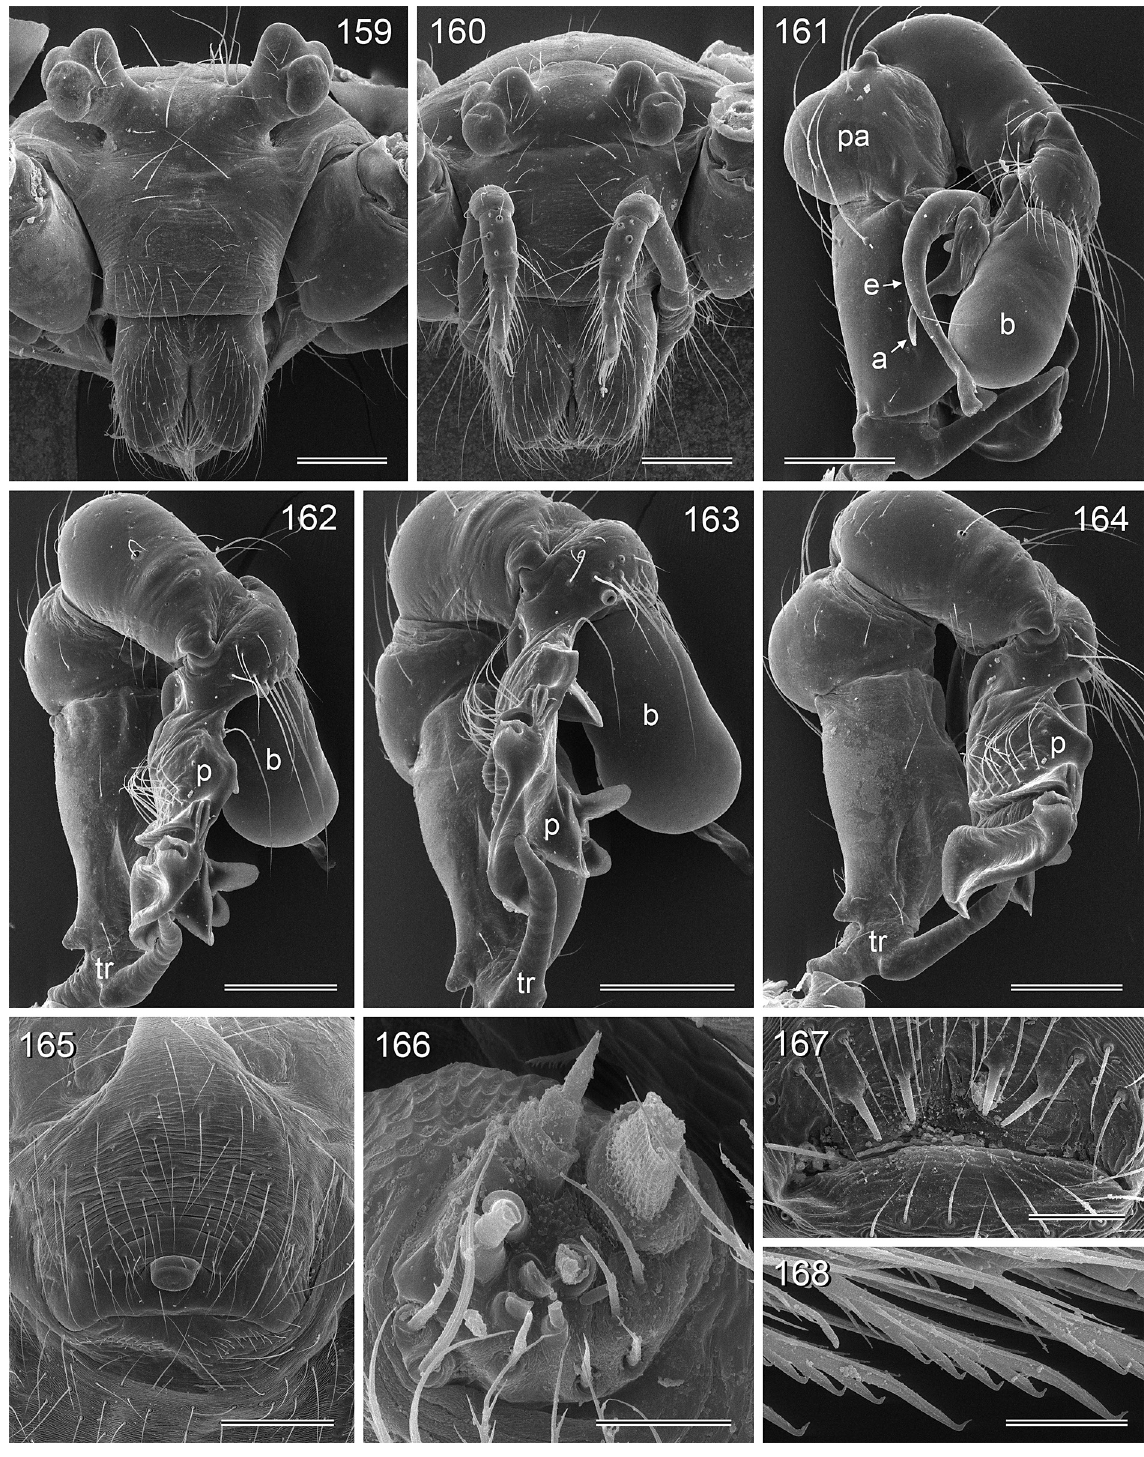
Figs 159–168. Pholcus buatong Huber, sp. nov., ZFMK Ar 15045. 159–160 . Male and female prosomata, frontal views. 161 . Left male palp, prolateral view. 162–164 . Right male palp, retrolatero-dorsal, dorsal, and retrolateral views. 165 . Epigynum, ventral view. 166 . Male ALS. 167 . Male gonopore. 168 . Comb- hairs on male tarsus 4. Abbreviations: a = appendix; b = genital bulb; e = embolus; p = procursus; pa = patella; tr = trochanter. Scale lines: 20 µm (166, 168); 40 µm (167); 200 µm